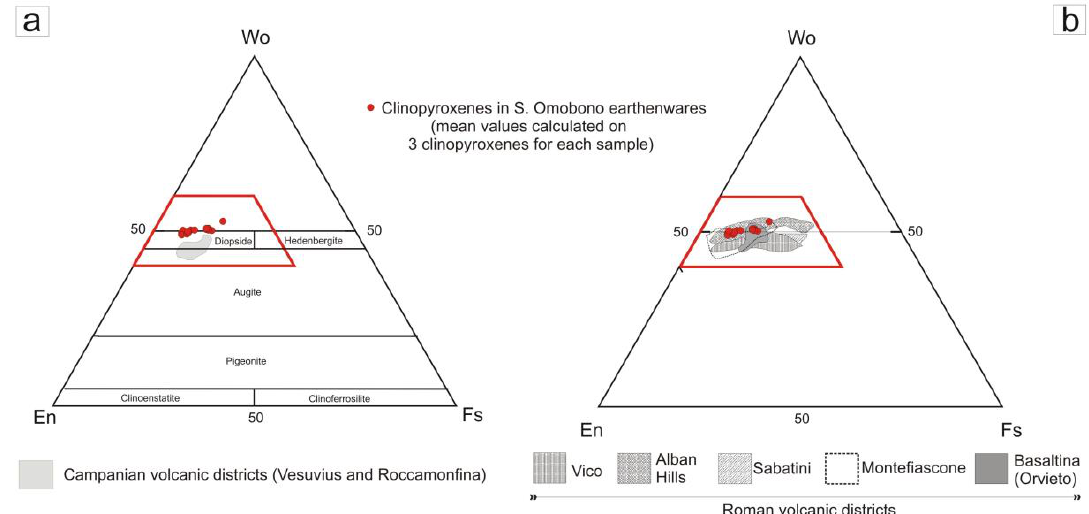
Figure 5. Classification of clinopyroxenes [59] using data obtained by EPMA and comparison between the composition of the clinopyroxenes analyzed in the archaeological samples of S. Omobono with those from the Campanian volcanic province ( a ) and the Roman volcanic complexes and districts ( b ).